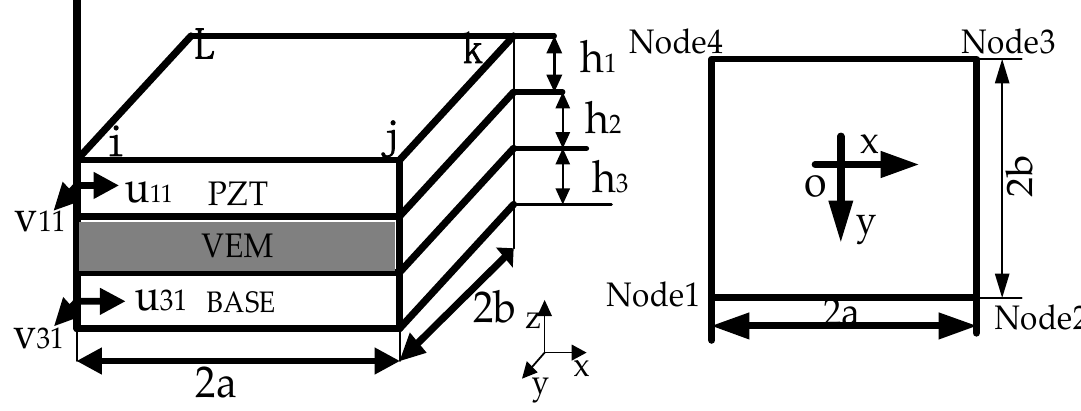
Figure 3. Schematic diagram of ACLD sandwich plates unit.